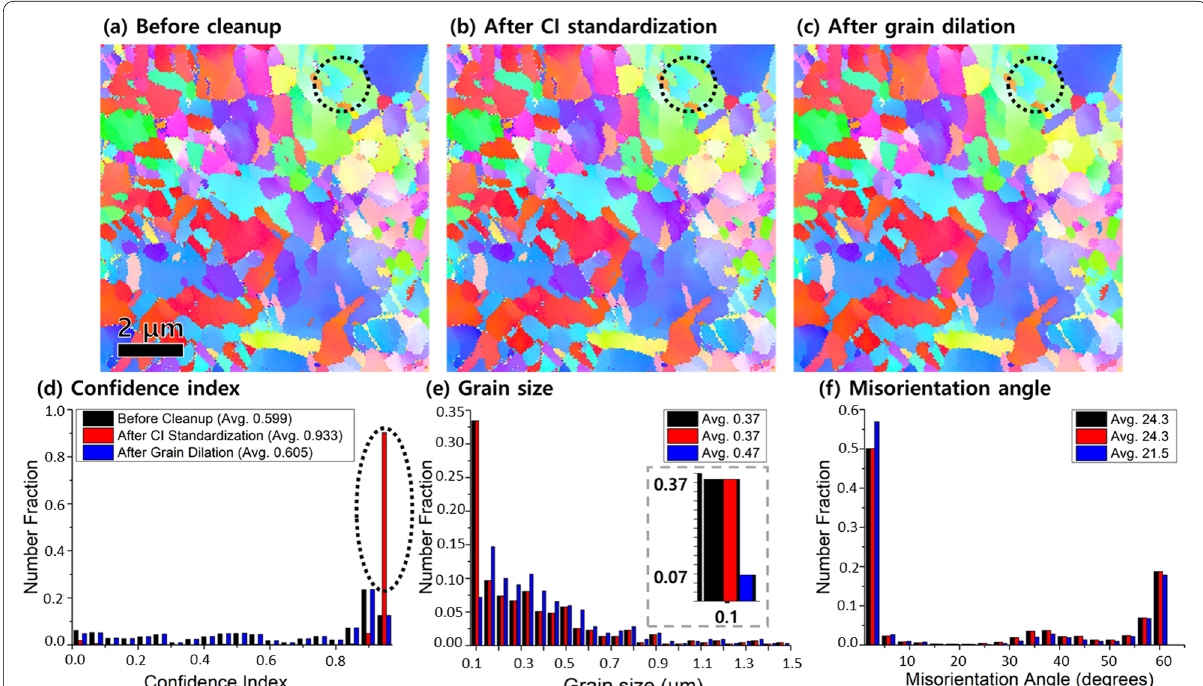
Fig. 3 EBSD IPF map a before cleanup, b after grain CI standardization, and c after grain dilation of copper foil in plane view. d Confidence Index, e grain size, and f misorientation angle graph of a , b , and